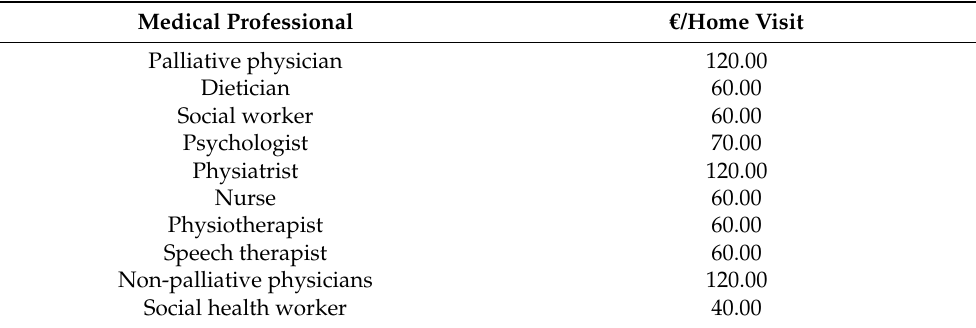
Table 1. Costs of home visits for health